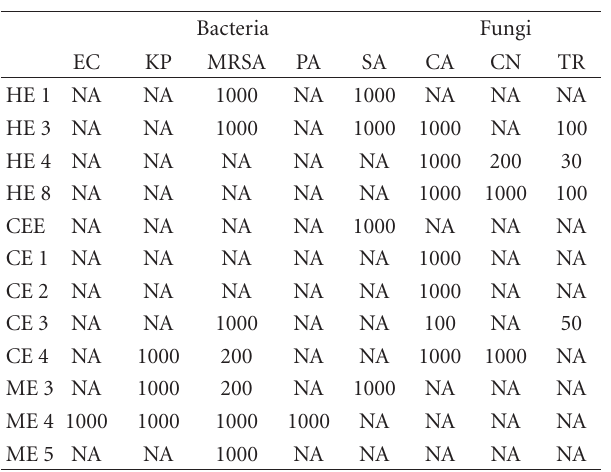
100 µ g/mL of the hexanic fractions (HE 3, HE 4, HE 8) (Table 1). No bioactivity was observed in the solvent control. No antifungal activities were detected against A. fumigatus .